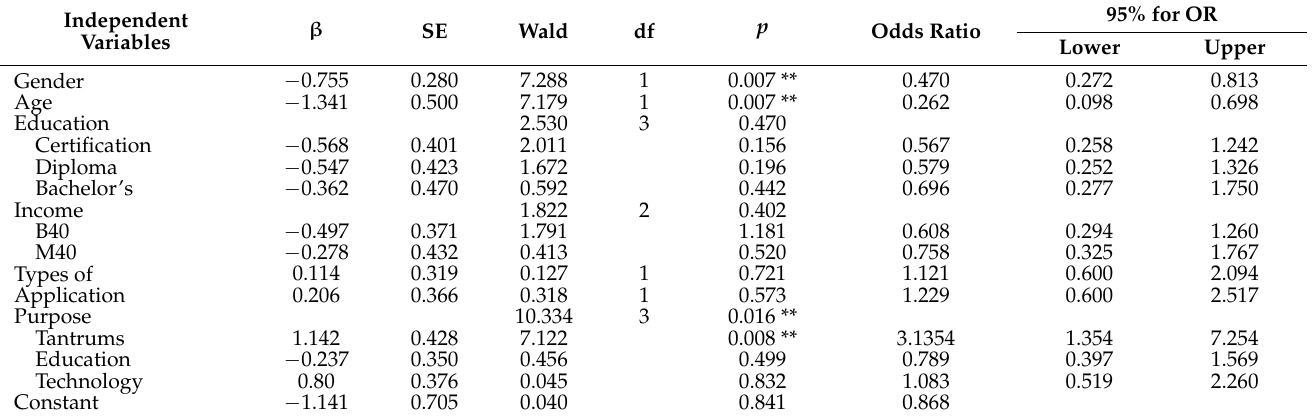
Table 7. Binary logistic regression analysis for potential factors for problematic